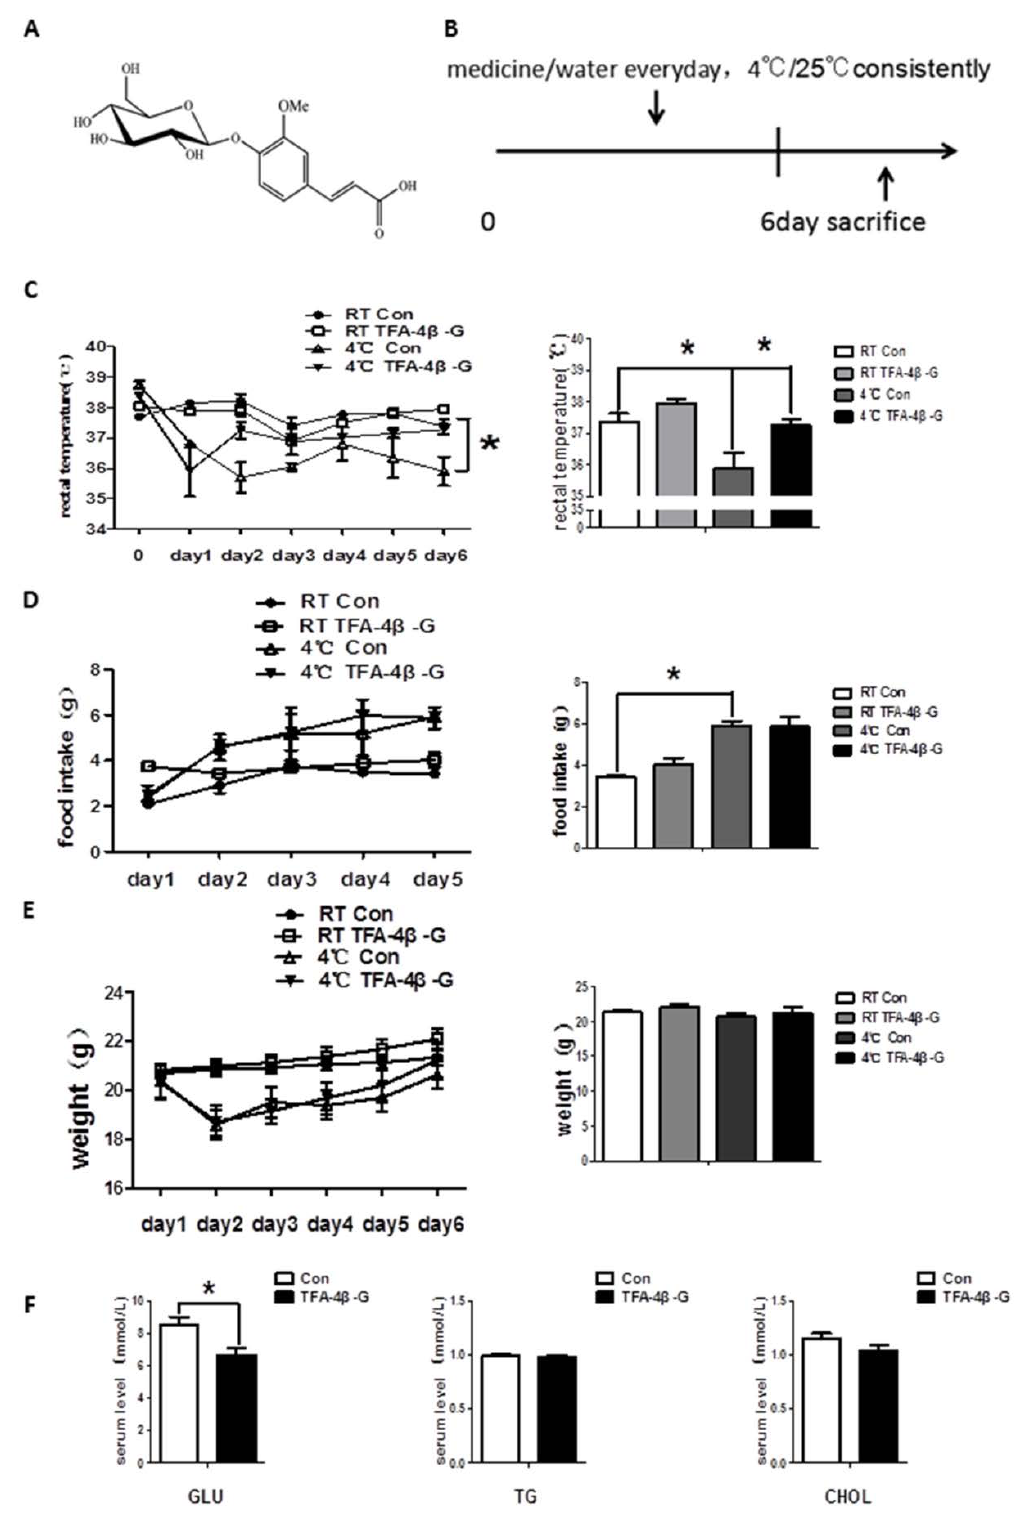
Figure 1. Trans -ferulic acid-4- β -glucoside treatment results in sustained, relatively high rectal temperature under cold conditions. ( A ) Molecular formula of TFA-4 β -G; ( B ) establishment of the animal model; ( C ) change in rectal temperature among four groups ( n = 6); ( D ) change in food intake; ( E ) change in body weight; ( F ) glucose, triglyceride, and cholesterol in serum. * p < 0.05 as indicated.